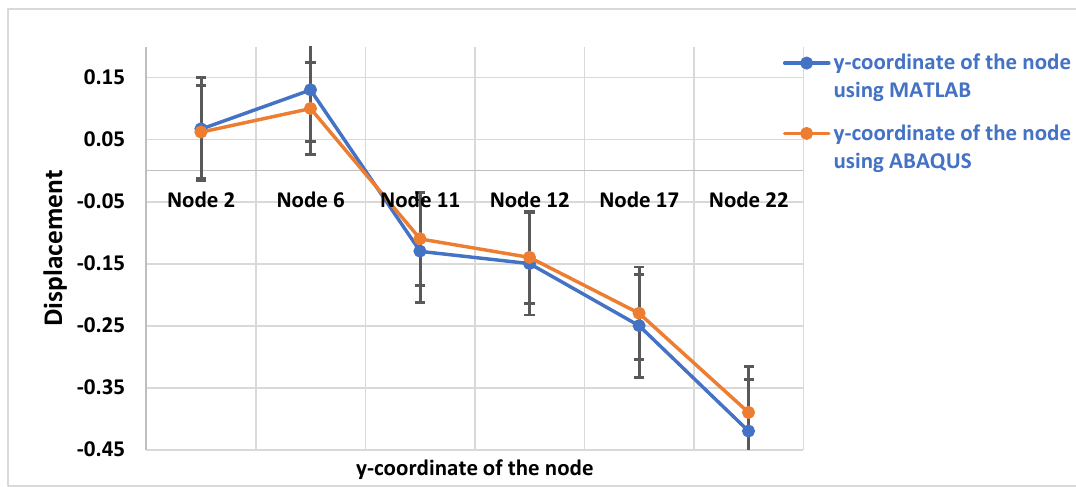
Figure 7. Comparison of the nodal displacements for the respective geometric position of x-coordinate using MATLAB and ABAQUS.